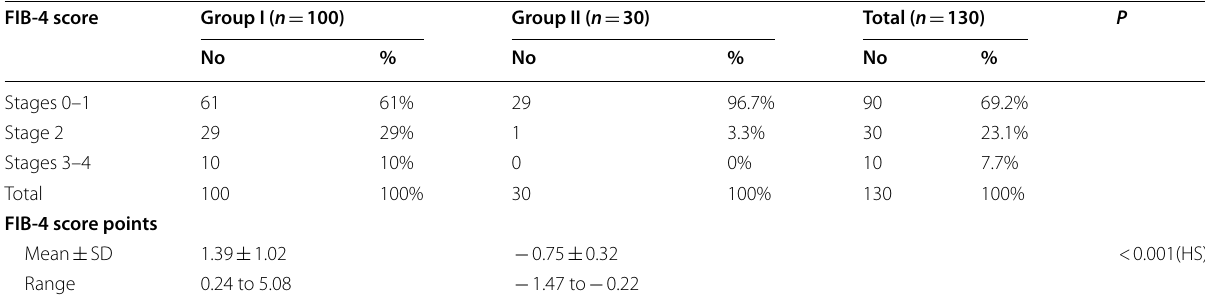
Table 2 FIB-4 score results among the studied groups